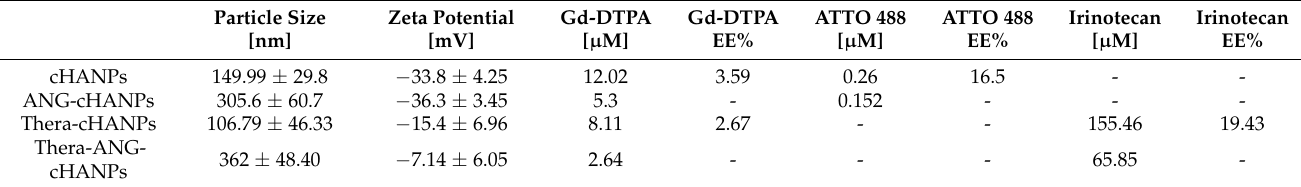
Table 1. Co-loaded cHANPs, ANG-cHANPs Thera-cHANPs and Thera ANG-cHANPs characterization.